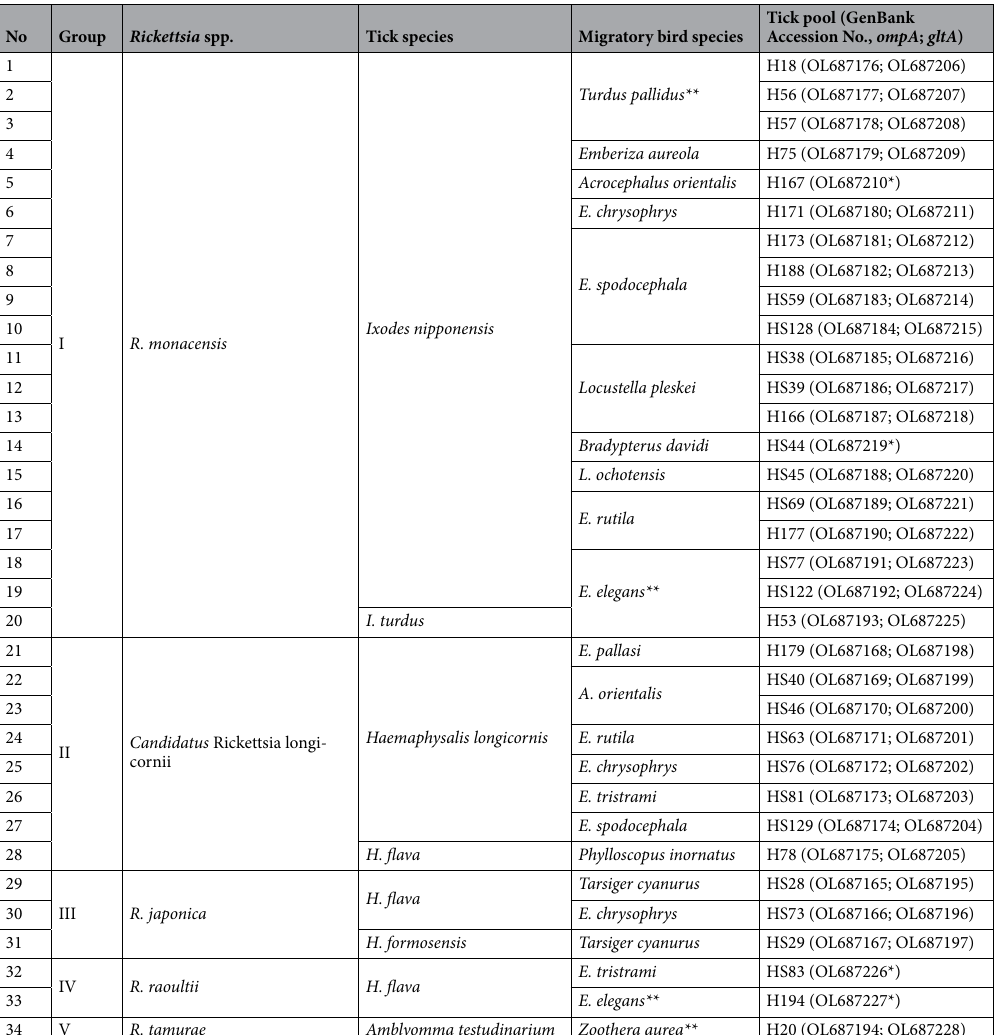
Table 2. The identified species of Rickettsia in bird ticks collected from 2010 to 2011 and in 2016. *Only gltA gene was amplified. **These species may be also regarded as residents or partial migrants in Korea, but the birds in this study were all true migrants that were crossing the national borders and ecological barriers like the Yellow